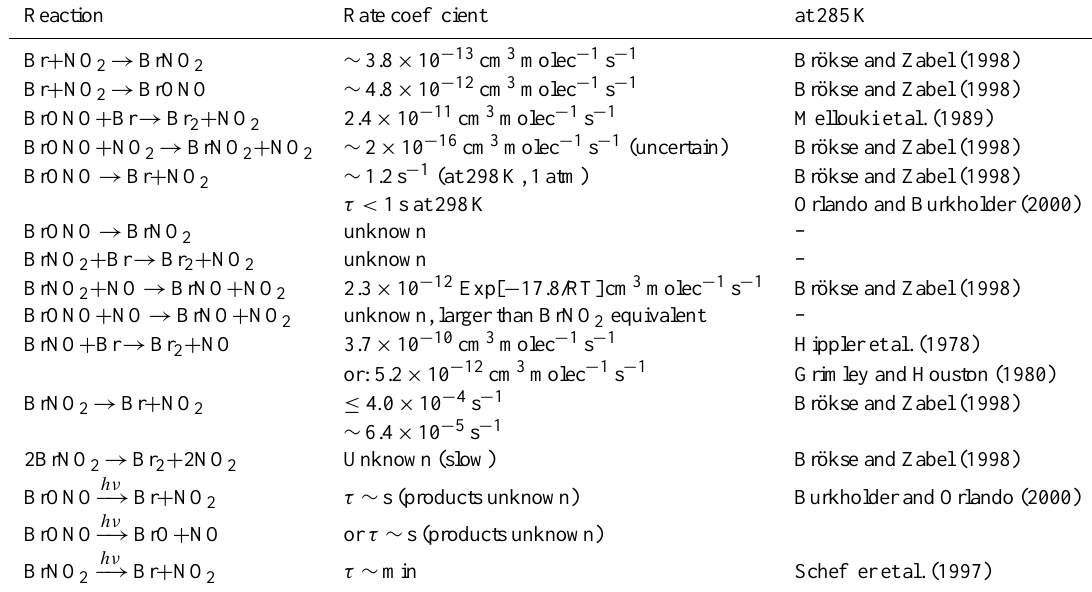
Table 3. List of gas-phase and photolytic reactions related to formation of BrNO 2 , BrONO and BrNO. Reactions listed are used in the – BrONO–BrNO scheme. The two-reaction BrNO 2 scheme assumes BrNO 2 as the sole product from both Br + NO 2 reactions and photolysis of BrNO 2 as the only loss pathway. See text for discussion of possible additional heterogeneous